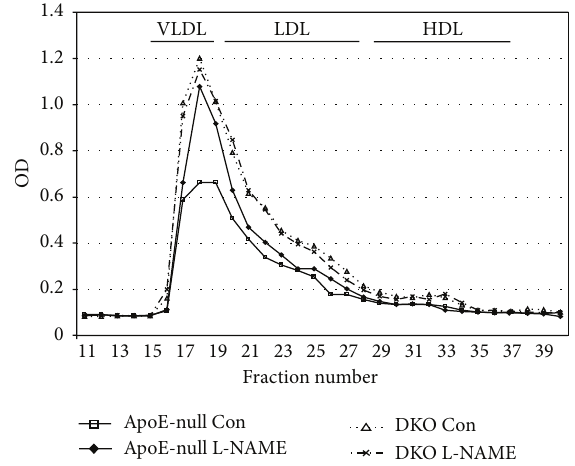
Figure 1: Lipoprotein FPLC analysis. Each curve represents the average of 4 samples, pooled from the sera of 2 mice each (error bars omitted for clarity). L-NAME increased VLDL cholesterol in the ApoE-null mice to the level seen in the DKO. DKO mice were not affected and maintained significantly higher LDL under all conditions ( 𝑃 < 0.01 for area under the curve,